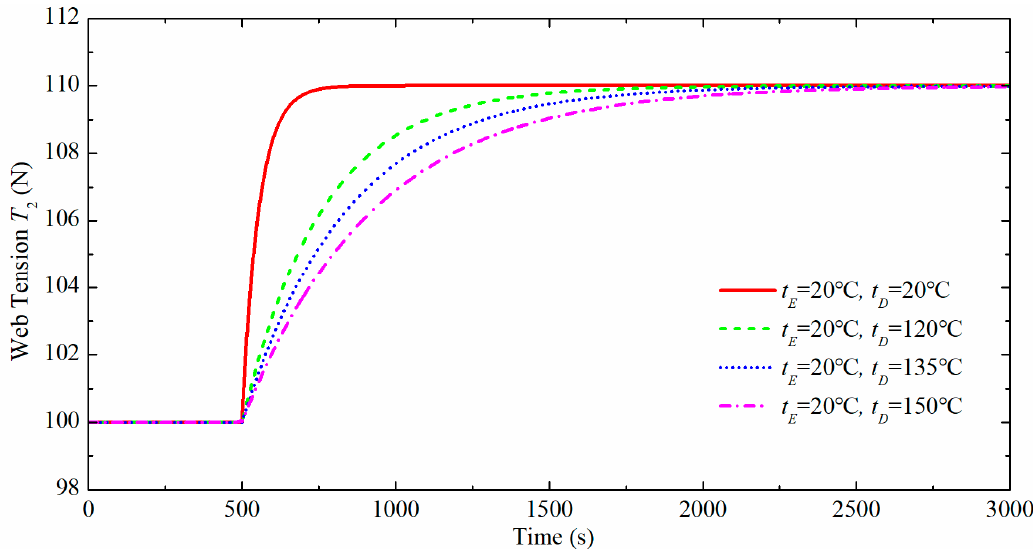
( ) T t as ( ) T t has step changes at different drying temperatures 2 1